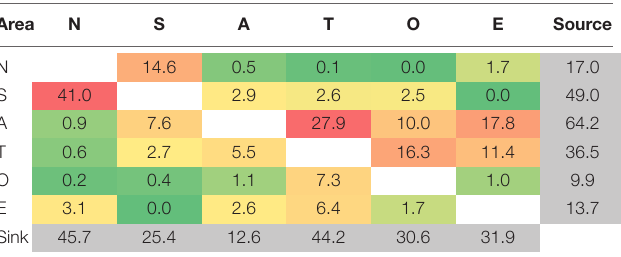
TABLE 2 | Numbers of dispersal events between the six biogeographic areas estimated by biogeographical stochastic mapping [BSM using M1s.dec; sum all dispersals (d) and range switching (a) events].